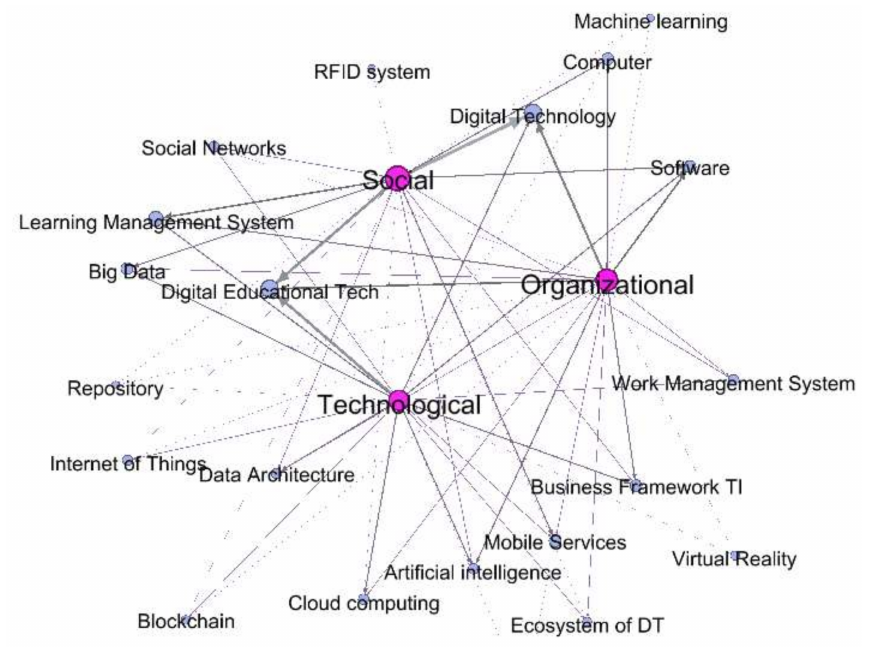
Figure 8. Technologies used in DT in